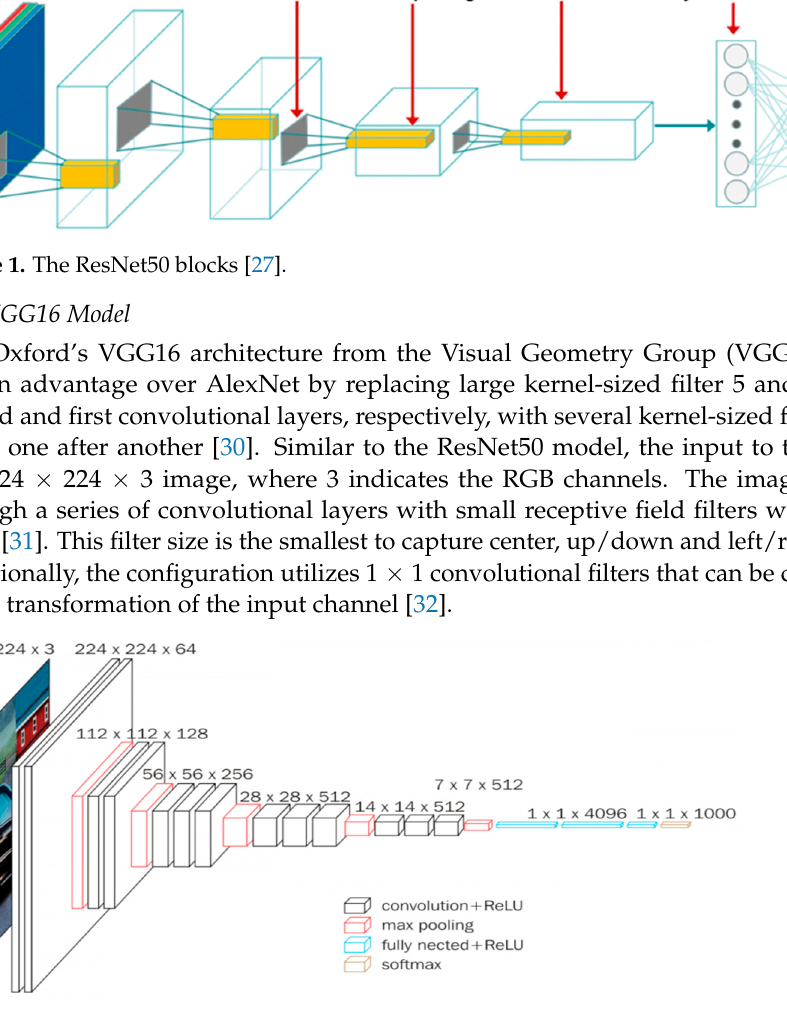
Figure 2. The VGG16 blocks [33].